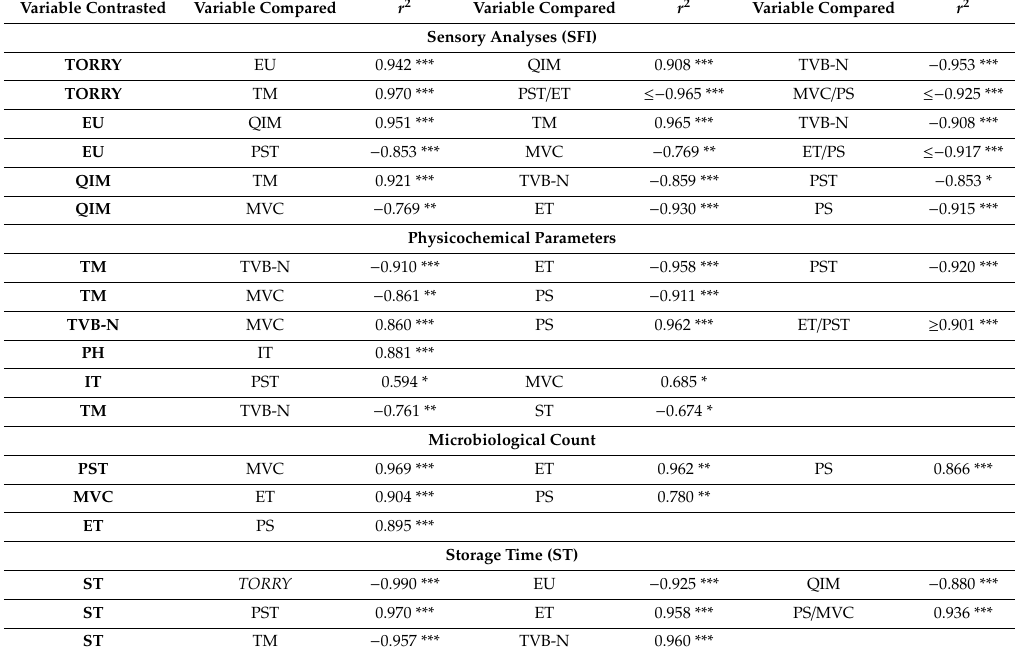
Table 2. Pearson correlation coe ffi cients among physico–chemical, microbiological and sensory results for sea bream storage in